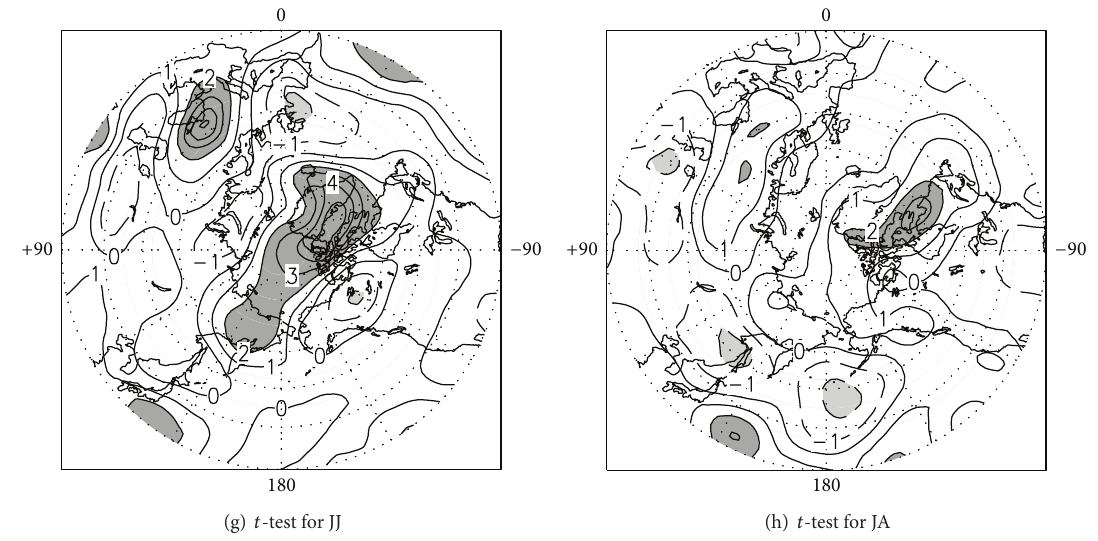
Figure 8: As in Figure 7 but for monthly 500 hPa GHT.